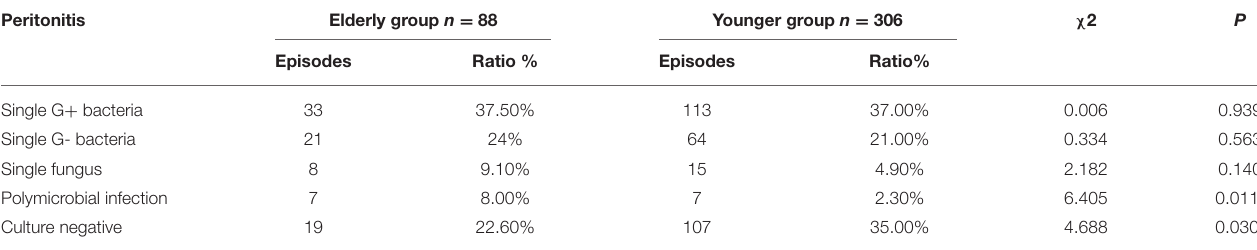
TABLE 3 | Classification of causative organisms culture in elderly and younger patients with